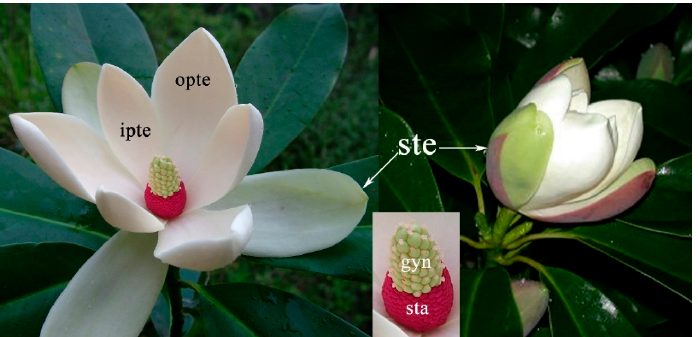
Figure 1. Flower of Manglietia patungensis . Shown are the sepaloid tepal (ste), outer petaloid tepal (opte), inner petaloid tepal (ipte), stamen (sta), and gynoecium